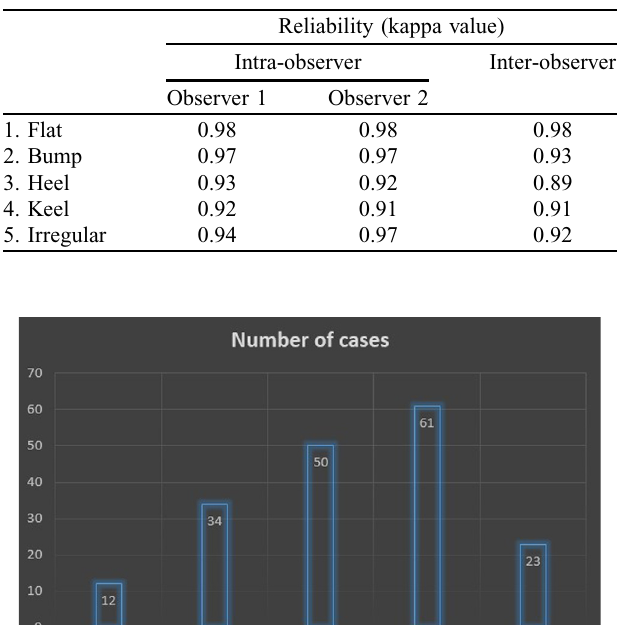
Table 3. Describes the correlation of the type of the acromion spur between the arthroscopic finding and the Rockwood tilt view.